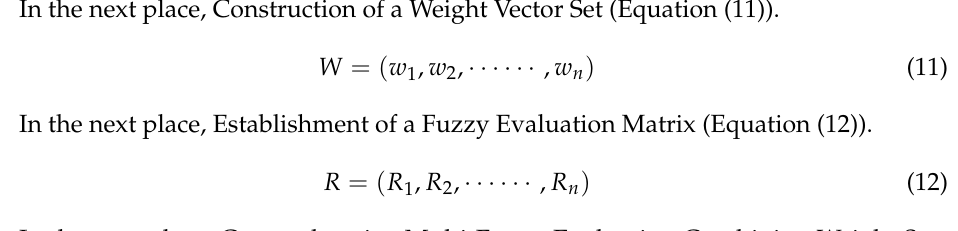
Table 5. Average random consistency index. Semantics Good Fairly Good Fair Fairly Poor Poor Semantic score 5 4 Evaluation